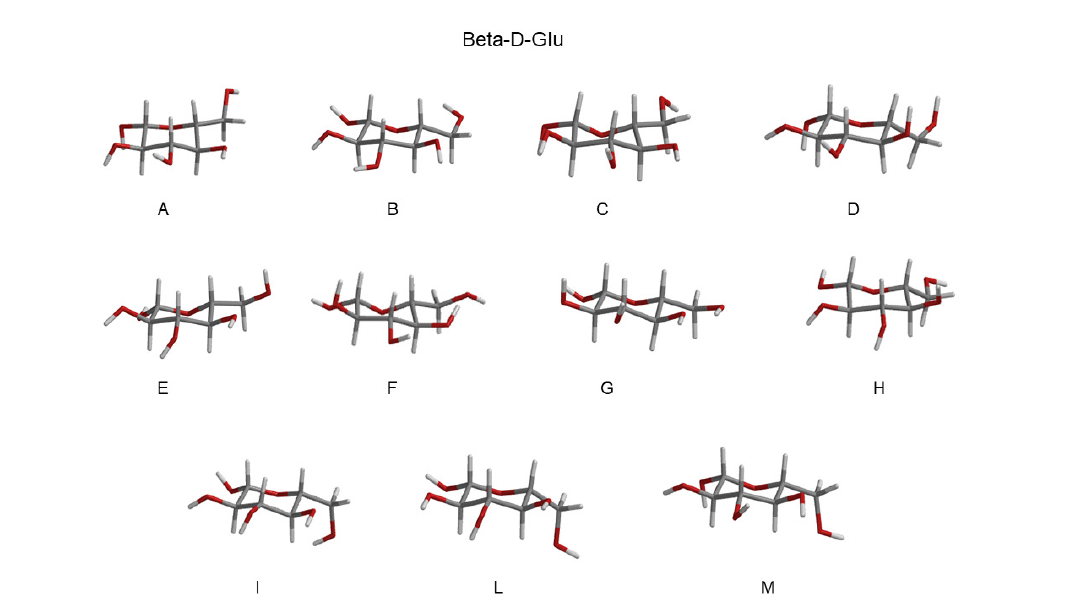
Figure 6. Schematic view of the Beta-Glu RCs extracted from the basins reported in Figure 4. Additional details can be found in the Supplementary